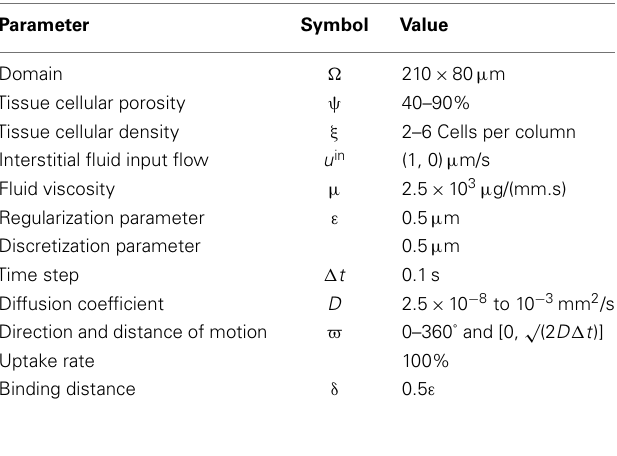
Table 1 | Model physical and computational